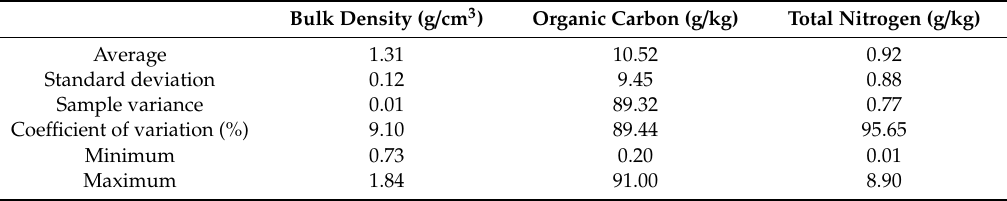
Figure 3. Direct and cross-experimental variograms of the original soil health indicators (SHIs): BD = bulk density (g/cm 3 ); TN = total nitrogen (g/kg); and OC = organic carbon (g/kg) (semivariance is expressed as units of each SHI, significance levels (*** p < 0.001) ). Table 1. Descriptive statistics of the examined soil health indicators in Nigeria